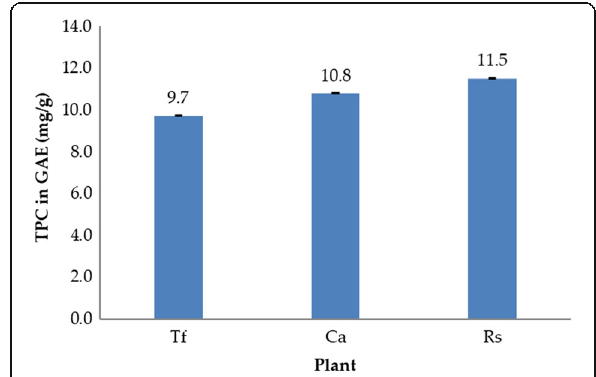
Fig. 1 Total phenolic content of T. foenum-graecum (Tf), C. acutifolia (Ca) and R. stricta (Rs) extracts determined by the Folin-Ciocalteau assay and calculated as mg GAE/g extract based on dry weight. Results are the average of triplicates ± SD Fig. 2 DPPH radical scavenging activities of the tested